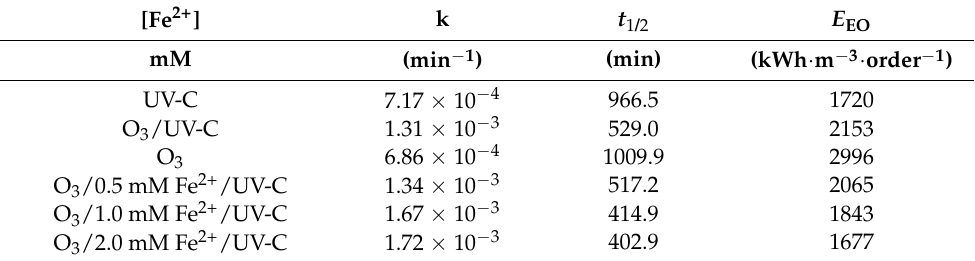
Table 6. Evaluation of first-order kinetic rate (k), half-life ( t 1/2 ) and electric energy per or- der ( E EO ) through the O 3 /Fe 2+ /UV-C process at different Fe 2+ concentrations (0.5–2.0 mM). P Ozonator = 0.025 kW, P UV-C = 0.015 kW, t = 10 h, V = 0.5